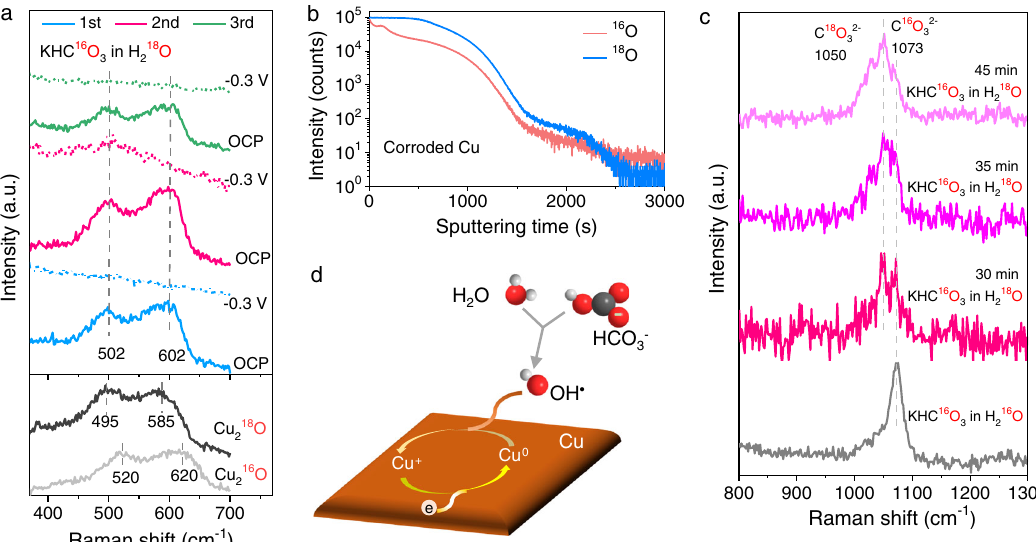
Fig. 6 Determination of OH (cid:129) sources by oxygen isotope labeling in Ar-saturated 0.5M KHC 16 O 3 H 2 18 O solution. a Raman spectra of surface Cu 2 O species under the loop tests with reduction at − 0.3 V RHE for 10 s and subsequently reoxidation at OCP for 20 s. The plots at the bottom show reference spectra for Cu 2 16 O and Cu 2 18 O. b 16 O and 18 O contents of the CuO x species at the Cu plates after 24 h oxidizing corrosion, measured by TOF-SIMS. c Raman spectra of carbonate species on the Cu electrode. Each spectrum was obtained after resting the solution for the indicated time. The bottom spectrum shows C 16 O 3 2 − vibration as a reference. d The proposed dynamic reduction/reoxidation process of surface OD-Cu during CO 2